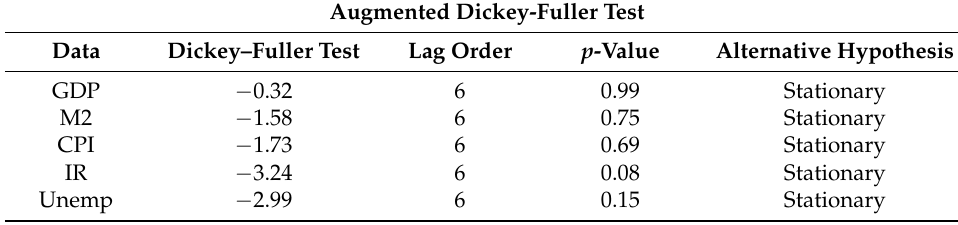
Table 2. Augmented Dickey-Fuller test.